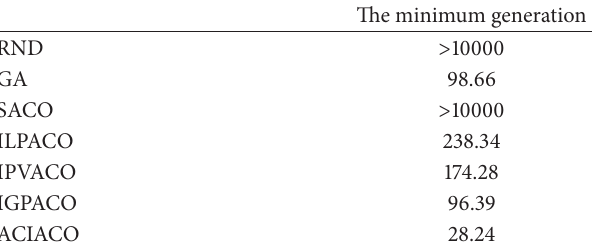
Table 7: The minimum